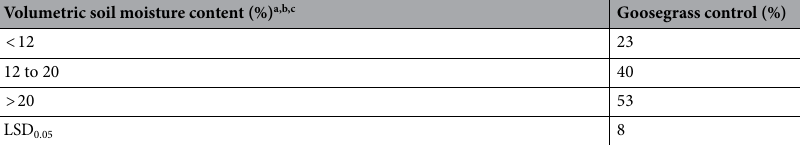
methyl + foramsulfuron + halosulfuron-methyl, and topramezone. In 2019, there was no soil moisture-by-her- bicide interaction; however, goosegrass control varied due to the main effects of soil moisture (Table 2) and